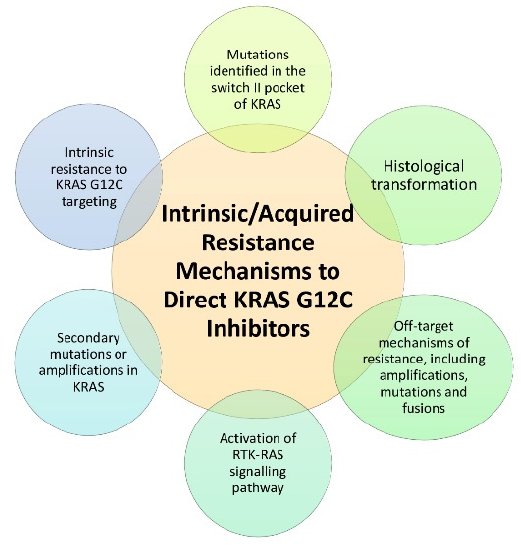
Figure 2. Mechanisms of resistance to direct KRAS G12C inhibitors.